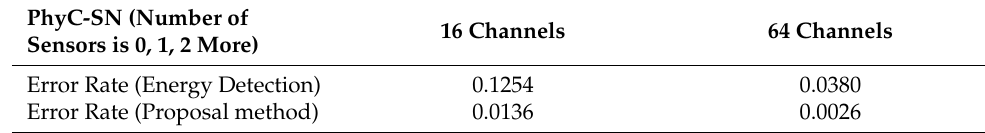
Table 3. Comparison of identification errors.